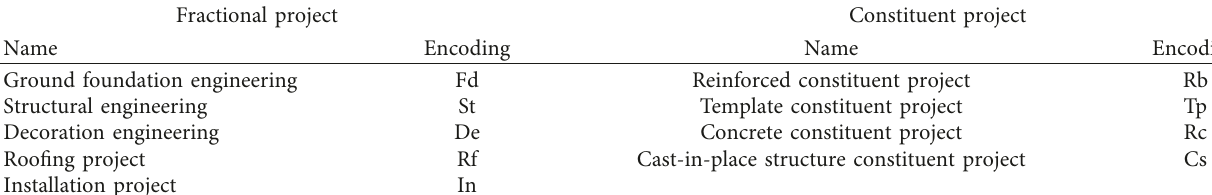
Table 9: Part of data encoding of fractional project.